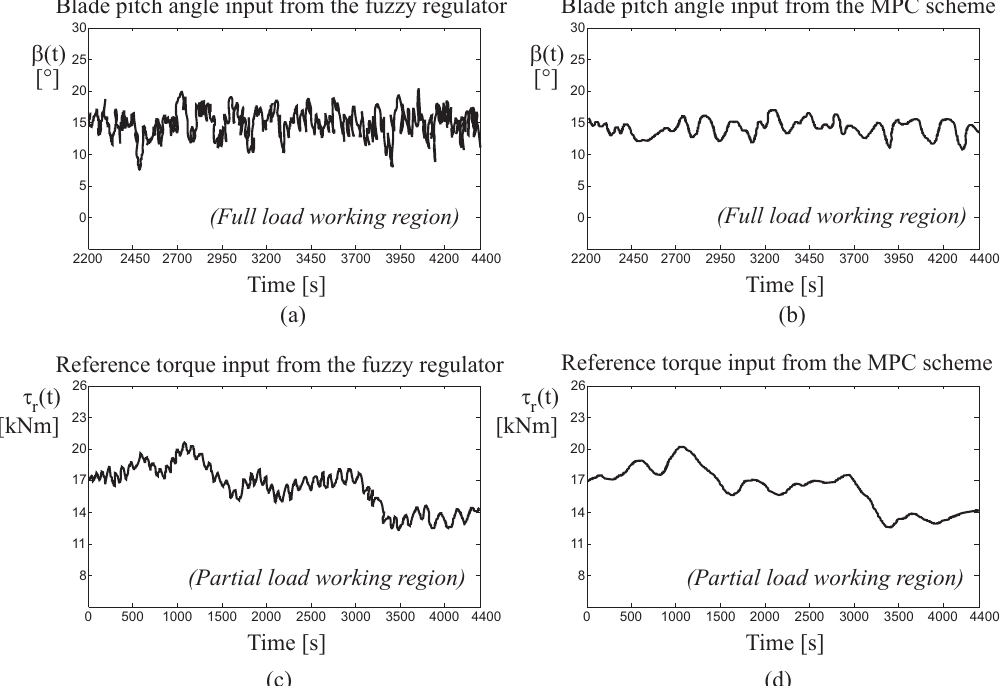
Figure 11. Wind turbine inputs ( a , c ) from the fuzzy control strategy and ( b , d ) by the MPC scheme.